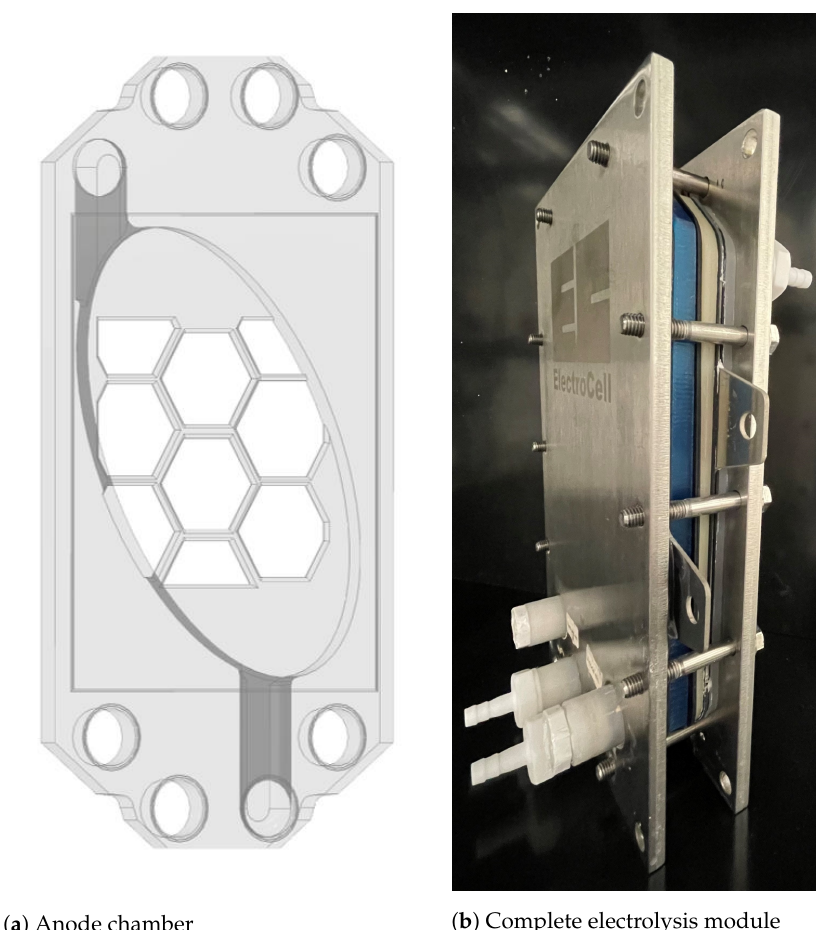
Figure 3. Drawing of the prototype for the electrochemical pH-shift crystallization on the left and on the right the prototype of the anode chamber (blue) integrated in the frameworks of the Electro MP Cell ®